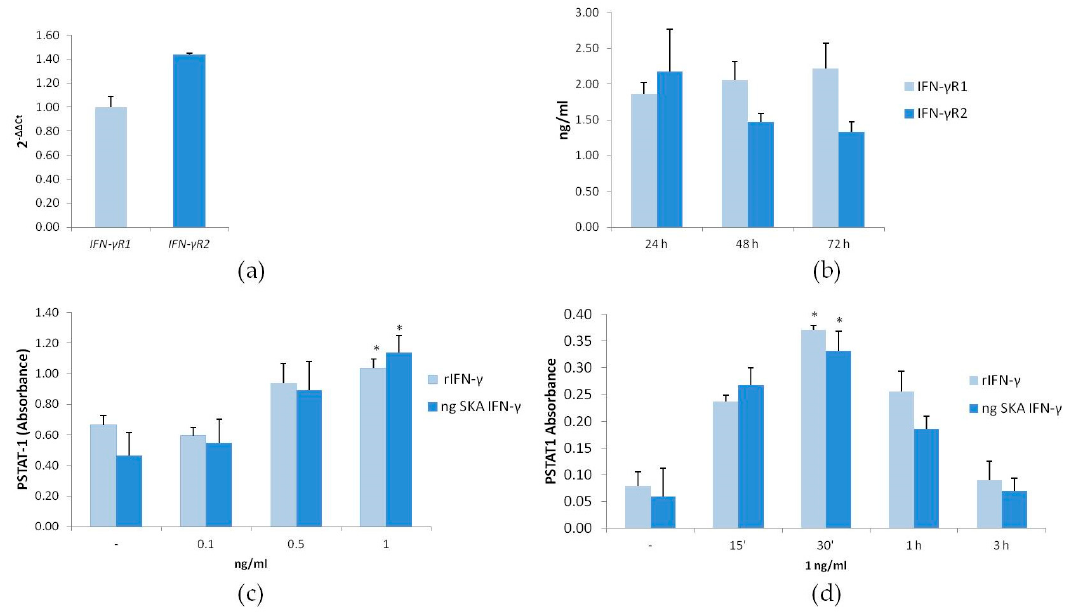
Figure 1. IFN- γ R levels under basal culture conditions and STAT-1 activation in response to rIFN- γ and SKA IFN- γ in the ng/mL range (ng SKA IFN- γ ). ( a ) After 24 h in culture, Jurkat cells were analyzed for IFN- γ R1 and IFN- γ R2 transcripts by Real-Time PCR and ( b ) for IFN- γ R1 and IFN- γ R2 protein level by ELISA after 24, 48, and 72 h of culture. ( c , d ) The phosphorylation of STAT-1 (PSTAT-